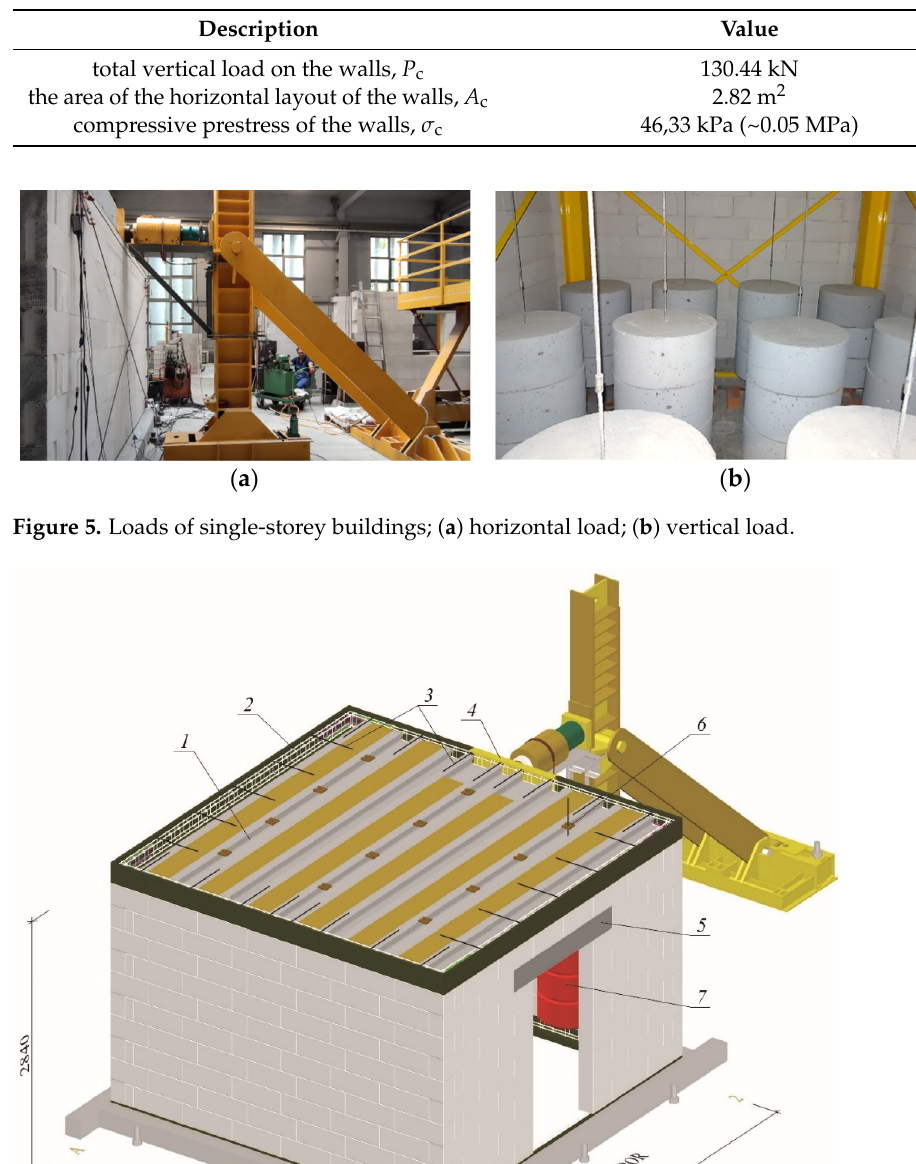
Table 2. Initial compressive stresses in the masonry walls.